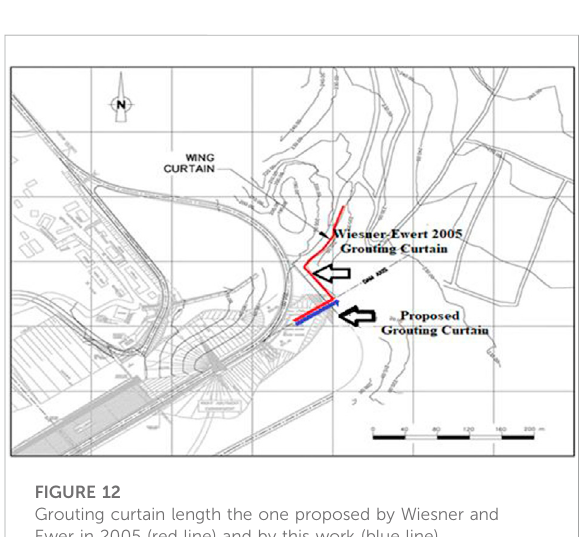
FIGURE 12 Grouting curtain length the one proposed by Wiesner and Ewer in 2005 (red line) and by this work (blue